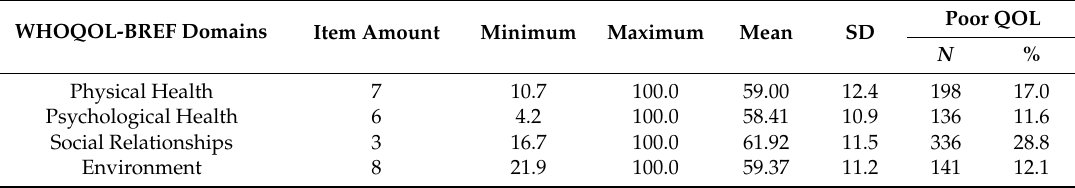
Table 4. Scores of the WHOQOL-BREF subscales among Chinese elderly ( n = 1168).